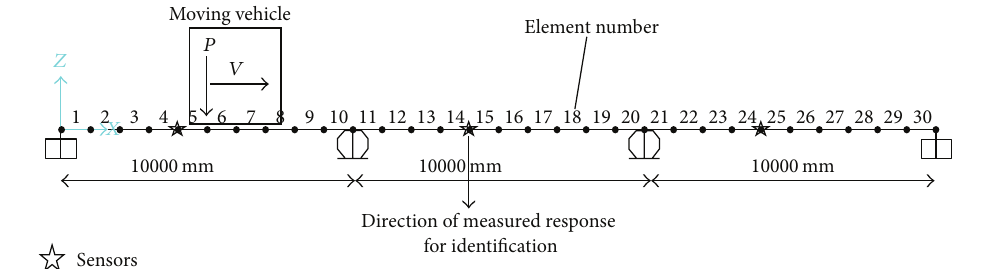
Figure 4: Multispan bridge model used in detection